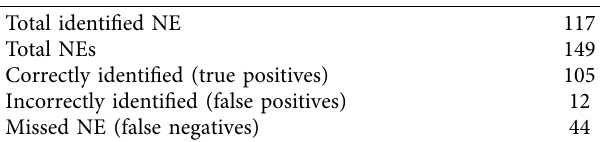
Figure 4: An example of annotated tokenized text. Table 3: Results of the